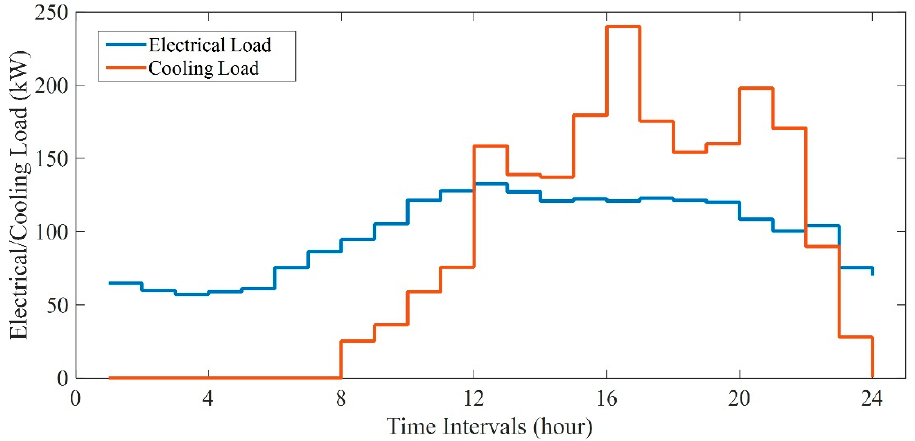
Figure A7. Electric / Cooling load curve for each period on the typical summer Figure A7. Electric/Cooling load curve for each period on the typical summer day.